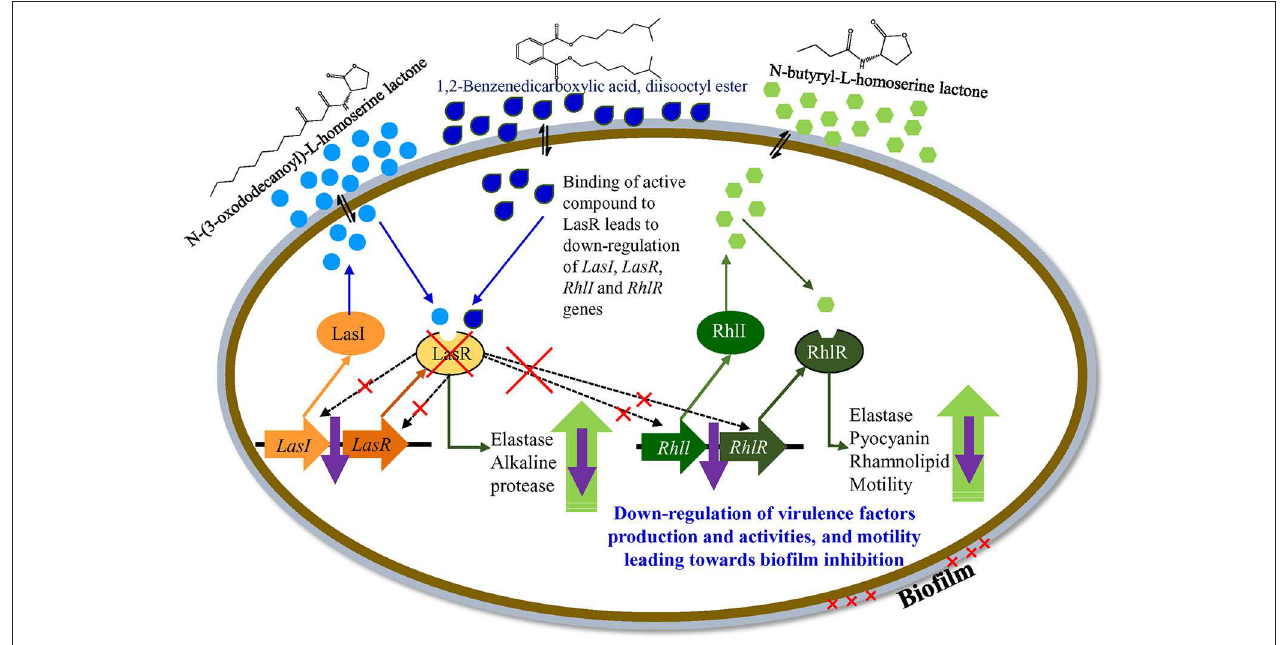
FIGURE 11 | A hypothetical model explaining transcriptional regulation of QSI in P. aeruginosa